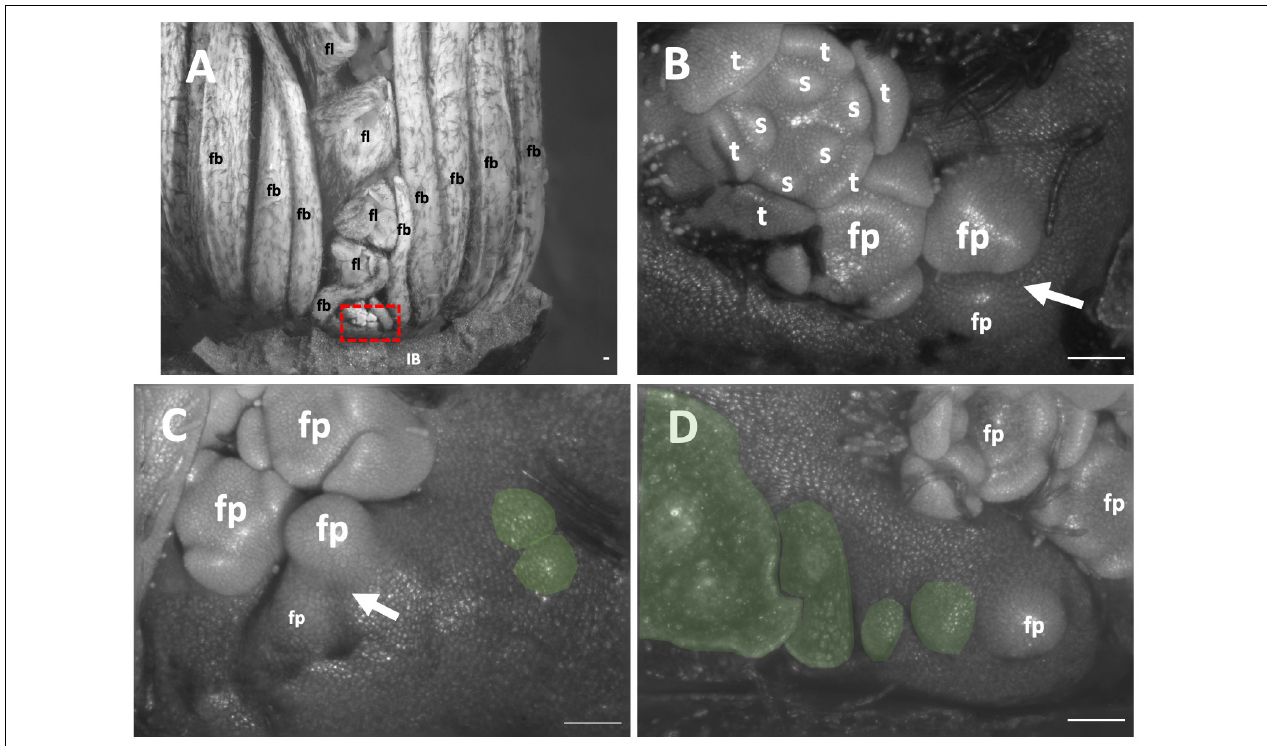
FIGURE 9 | Tacca chantrieri inflorescence developmental morphology. (A) One of the two lateral cincinni on an inflorescence. (B) A zoom-in of red box in panel A. (C) Cincinnus with a branching event and two newly formed bract primordia (false colored green). (D) Cincinnus that is not currently branching, with two floral bract primordia, the two oldest bracts have been dissected but scar is false colored green. White arrows indicate branching events. IB, Inflorescence bract; fb, floral bract, false colored green (C,D) fp, floral primordia; fl flower; t, tepal primordia; s, stamen primordia. White arrows indicate branching events. Scale bar of all images: 100 µ